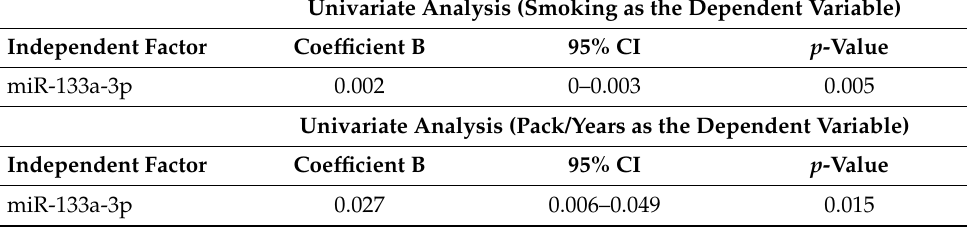
Table 5. Levels of miR-133a-3p were independently associated with the smoking status in AD patients in univariate linear regression